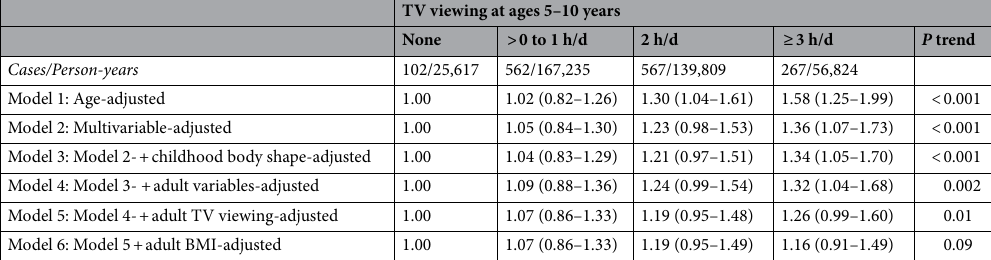
Table 3. Hazard ratios and 95% confidence intervals for adult diabetes incidence by category of television viewing at the ages 5–10 years among 34,431 participants of the Nurses’ Health II cohort between 2001 and 2013. TV television. Model 1: adjusted for age of nurse (continuous) and follow-up cycle. Model 2: same as model 1 but with additional adjustment for race (White, Non-White), family history of diabetes (yes, no),